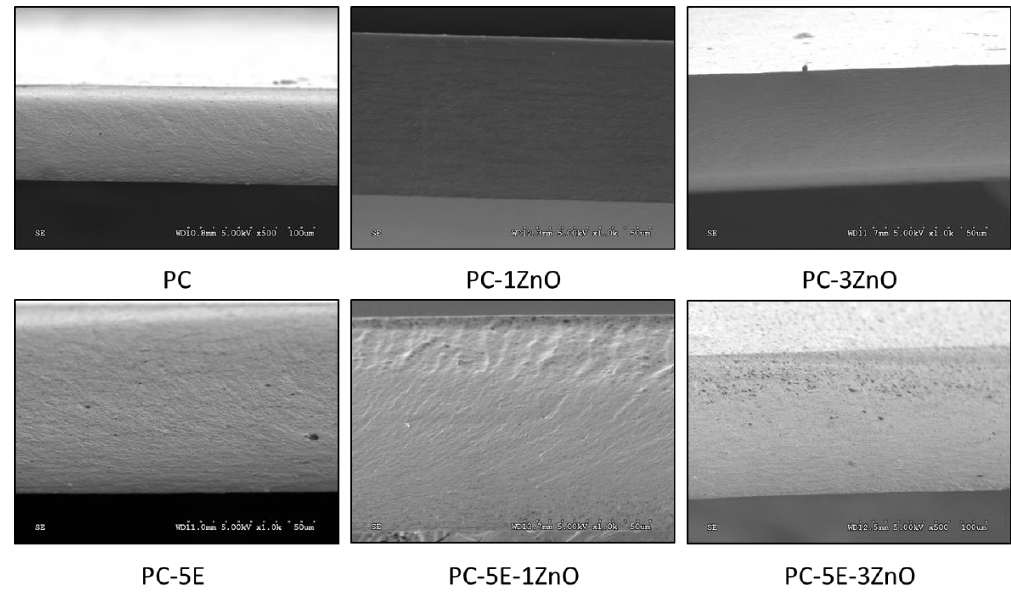
Figure 8. SEM micrographs of cross-sections of pectin-based films.